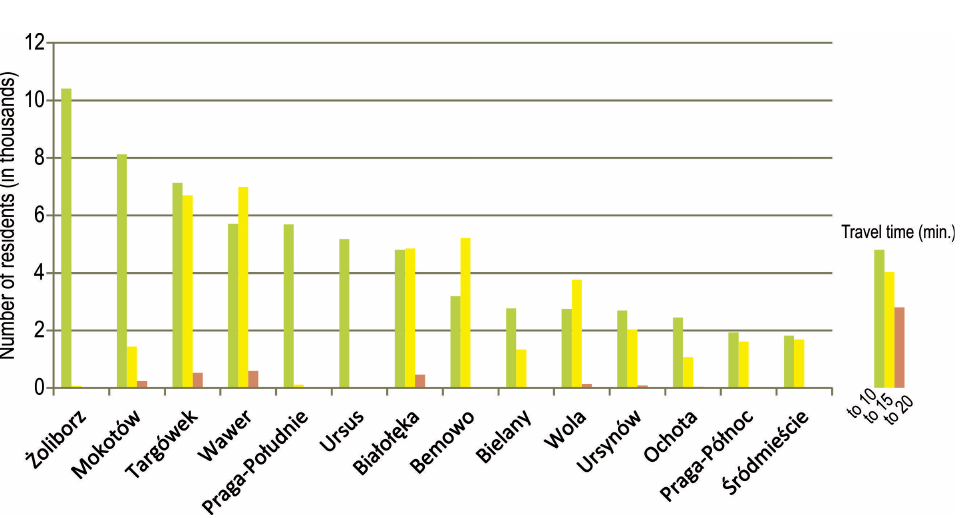
Fig. 5. Number of residents in the district per 1 paramedic at Meditrans station (own